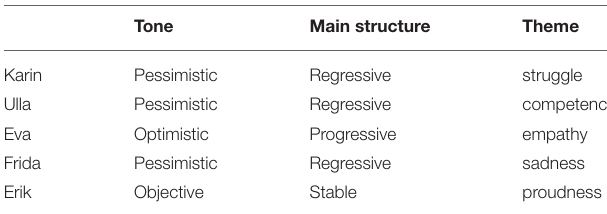
TABLE 2 | The manifestation of the narrative in tone, main structure and